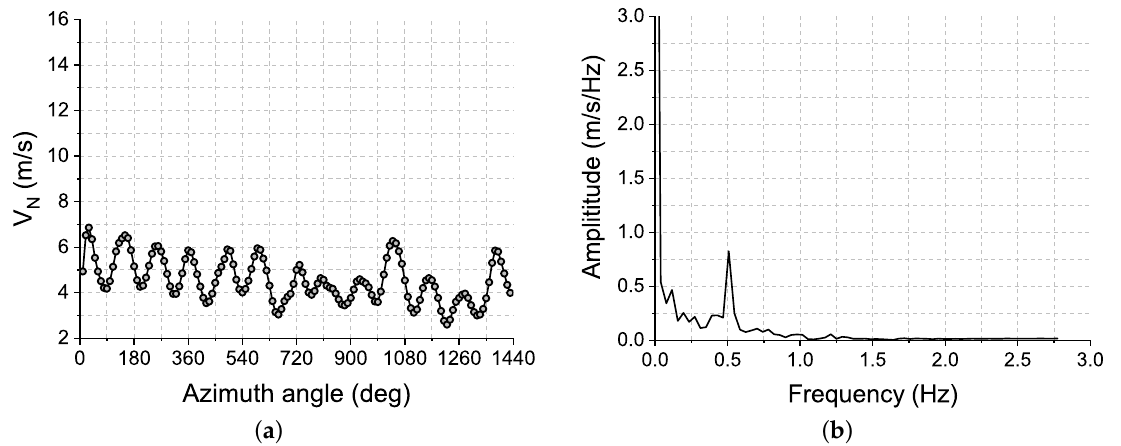
Figure 12. Variation of V N at low wind speed, 5m/s. ( a ) Time domain. ( b ) Frequency domain.